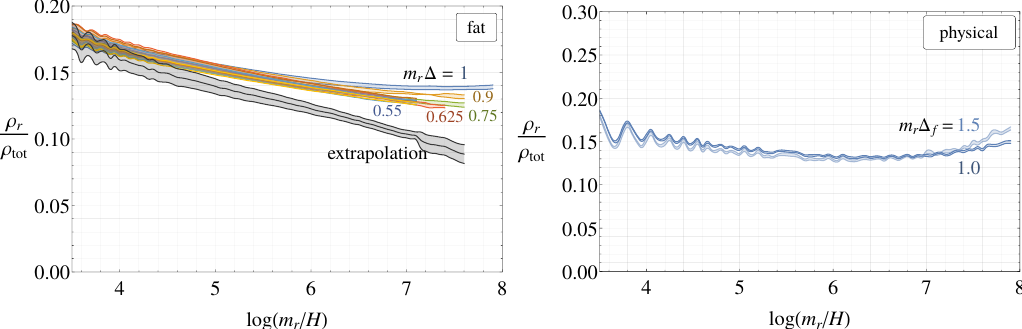
Figure 10: The fraction of total energy density in simulations that is in radial modes for physical strings (right) and fat strings (left). The results are shown for different lattice spacings, and the continuum extrapolation is also plotted for the fat string system. As log grows this fraction decreases for fat strings (after the continuum extrapolation), which suggests that radial modes decouple and are increasing irrel- evant for the string dynamics. The results for physical strings show a similar trend, although we do not perform the continuum